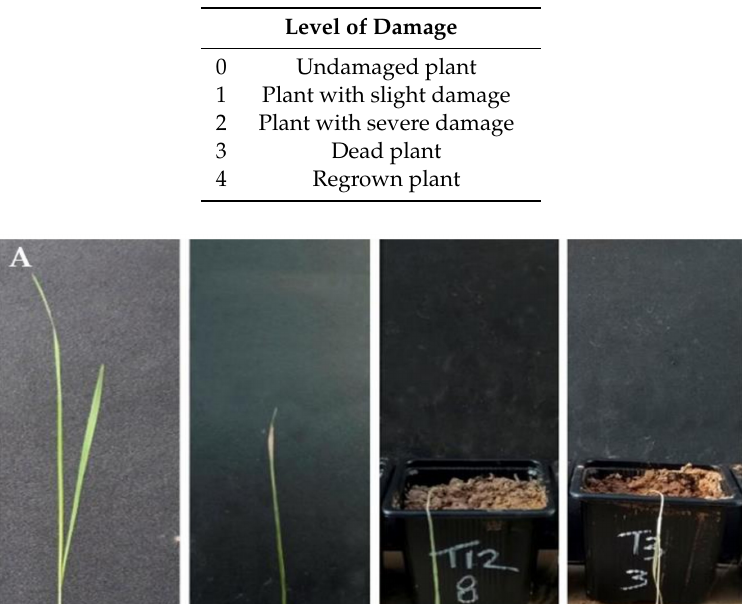
Table 4. Damage level assessment.